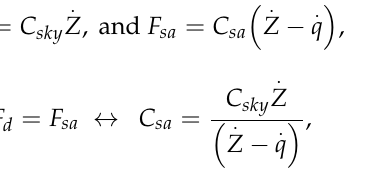
Table 1. Details of the RSD inspection car’s components. Parameters Values Stiffness of the rubber, K s (kN/m) 50 Damping coefficient of the rubber, C s (N · m/s) 50 Compliance of the upper chamber, C 1 (m 5 /N) 2 × 10 − 10 Compliance of the lower chamber, C 2 (m 5 /N) 2 × 10 − 8 Effective area of the upper chamber cross-section, Ap (m2) 7.065 × 10 − 4 Gap of MRF, g (m) 0.002 Outer radius of the magnetic part R mp (m) 0.03 Equivalent viscous coefficient caused by MRF, R µ (Ns/m5) 9.91 × 10 7 Ratio of the effective area caused by the magnetic field, k t 0.58 Weight of the sprung mass per each mount, m (kg) 15 Density of MRF 140-CG (kg/m − 3 )